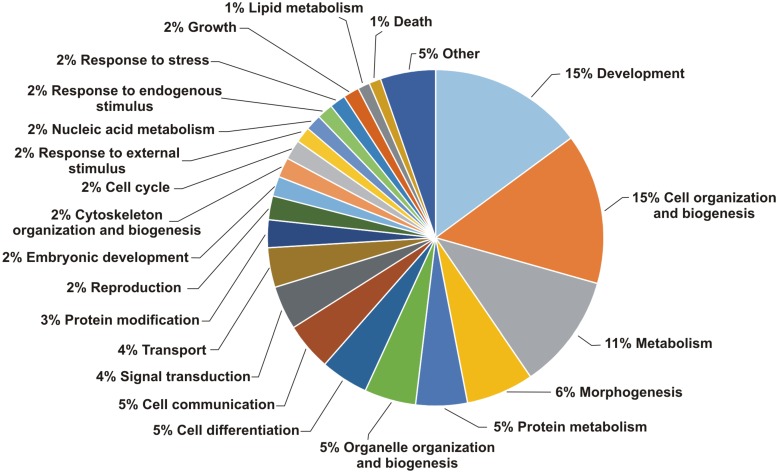
Gene Ontology classification of Pfam conserved domains found in 198 novel protein coding genes.The percentage of Pfam domains in each of the biological process categories of GO categorization was determined. A total of 232 new protein-coding genes presenting 152 different Pfam domains were assigned to 208 biological processes by the dcGO tool, and with the CateGOrizer tool it was possible to categorize GOs by single counting. Categories with less than 1% representation were grouped together.